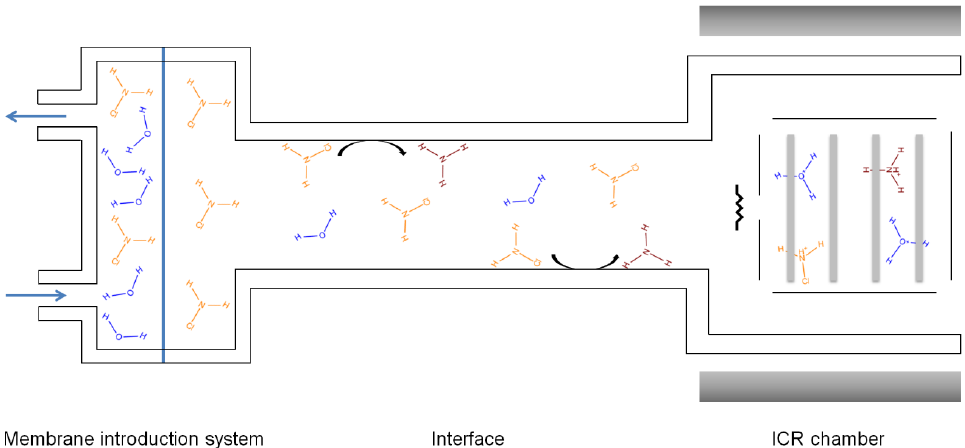
Figure 7. Schematic representation of the adsorption/desorption and surface catalyzed decomposition phenomena.